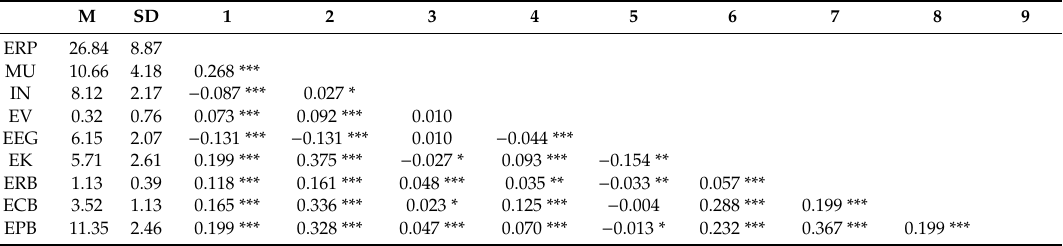
Table 1. Descriptive Statistics and Inter-correlations of the